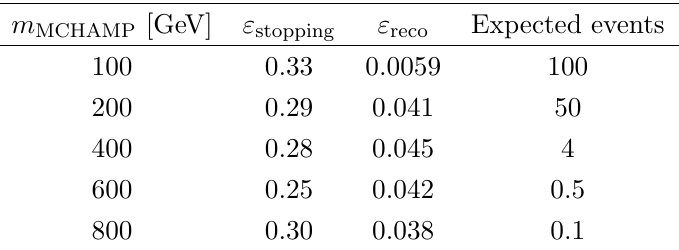
Table 3 . MCHAMP " stopping and " reco , as well as the number of expected MCHAMP events with lifetimes between 10 (cid:22) s and 1000 s, assuming B (MCHAMP ! (cid:22) (cid:6) (cid:22) (cid:6) ) = 100%, for each mass point considered for the 2016 muon search. The e(cid:14)ciencies are constant for this range of